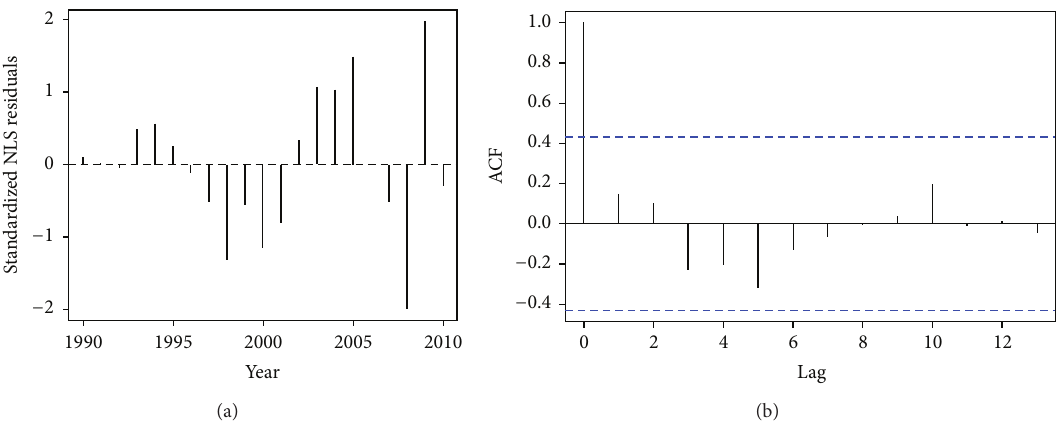
Figure 6: NLS residuals and their autocorrelation